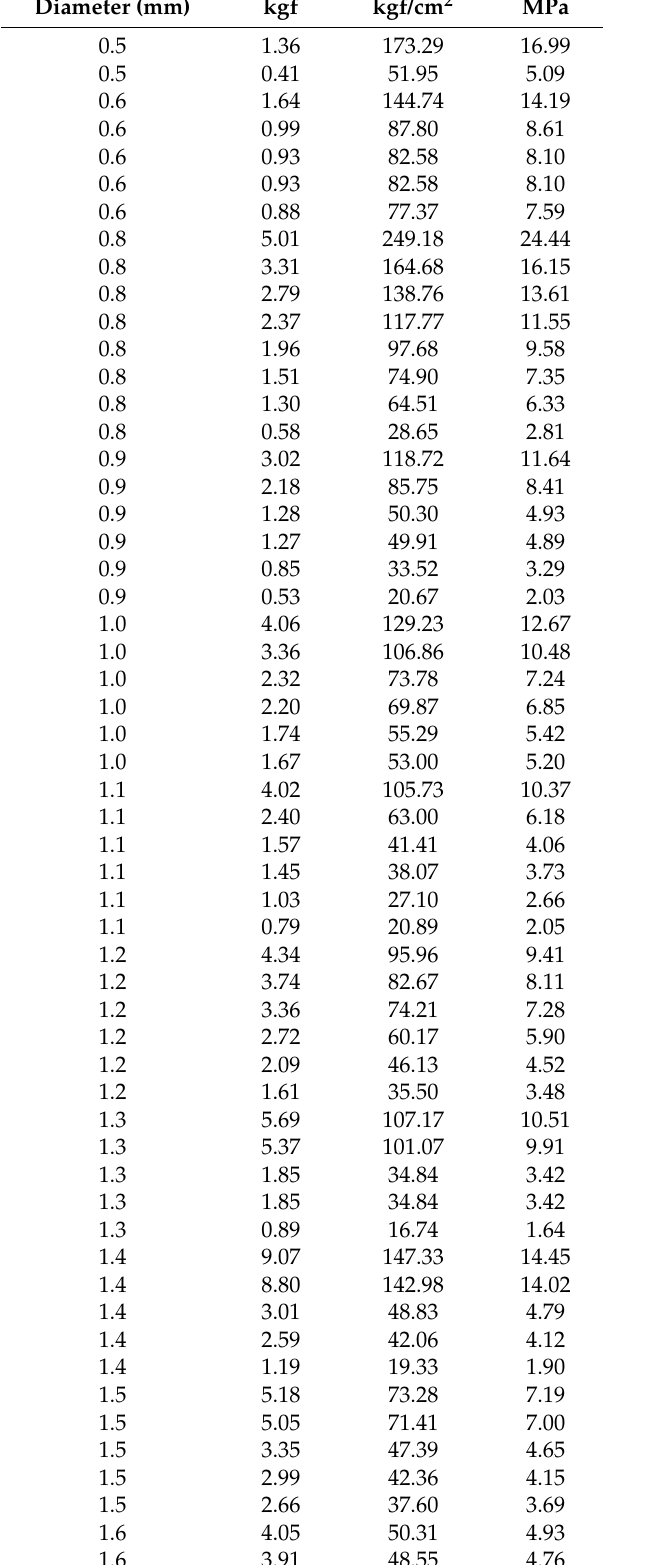
Table A7. Summary of all root tensile strengths, in MPa, measured for Arundo donax . Plant Type